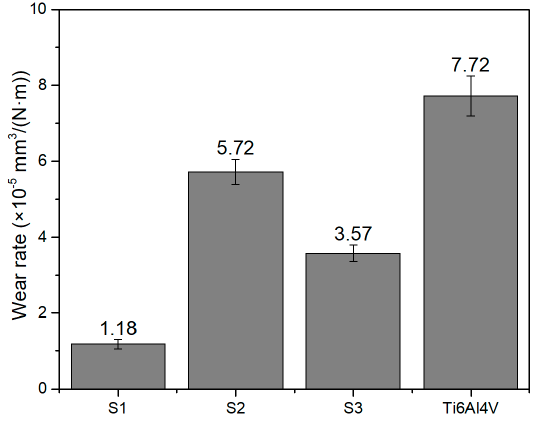
Figure 10. Wear rates of coated and uncoated Ti6Al4V alloy.